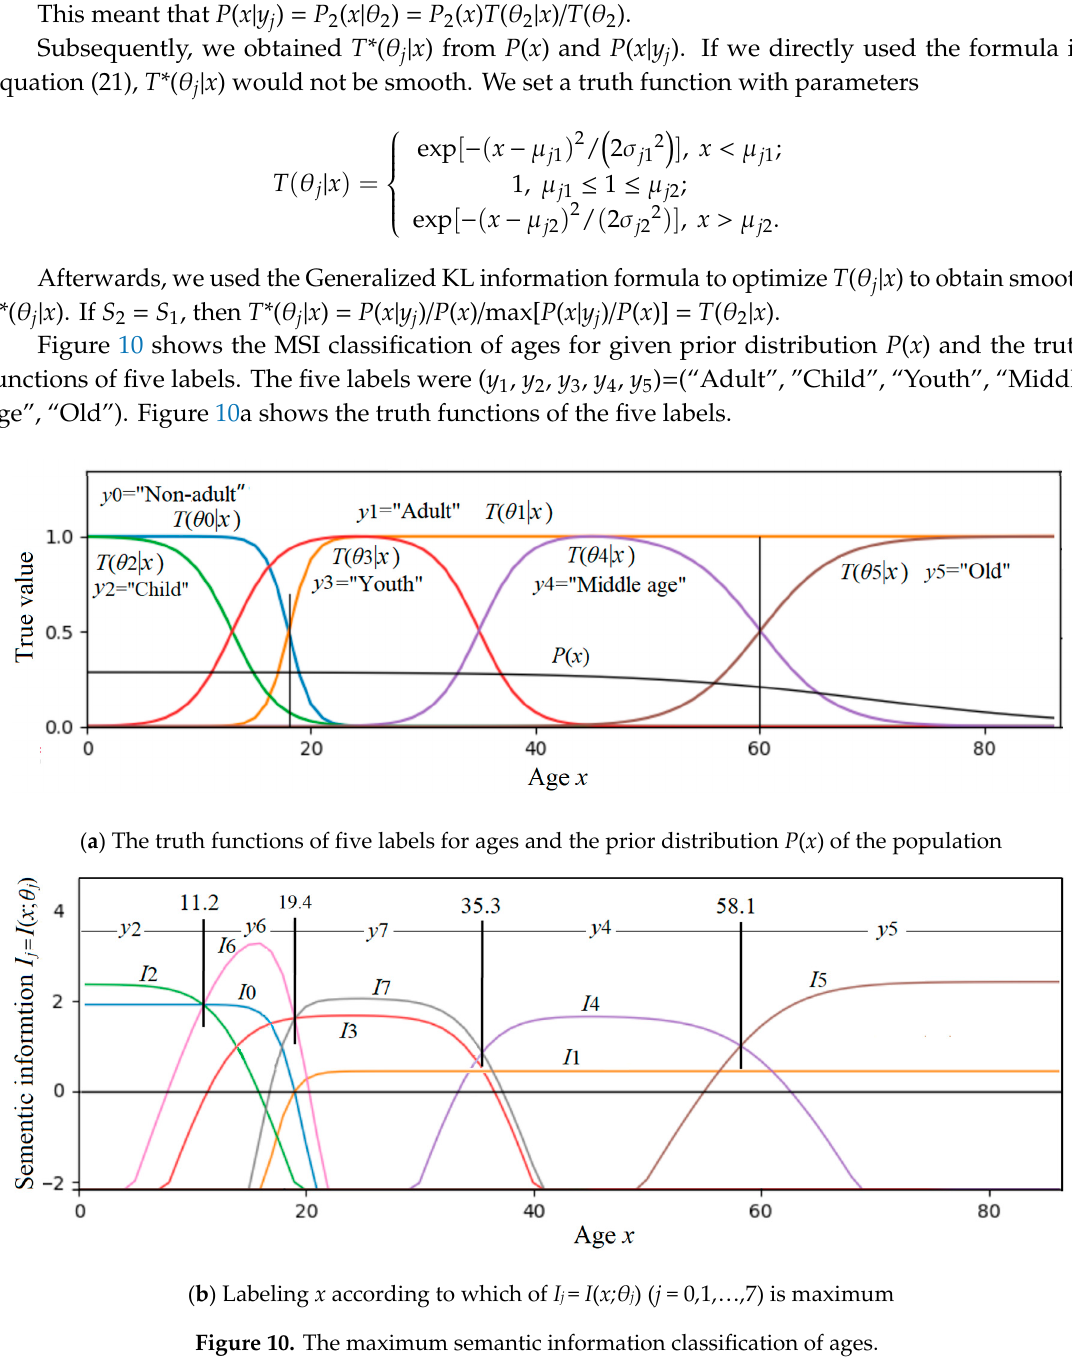
Figure 9. Using prior and posterior distributions P ( x ) and P ( x|y j ) to obtain the optimized truth function T* ( θ j | x ).